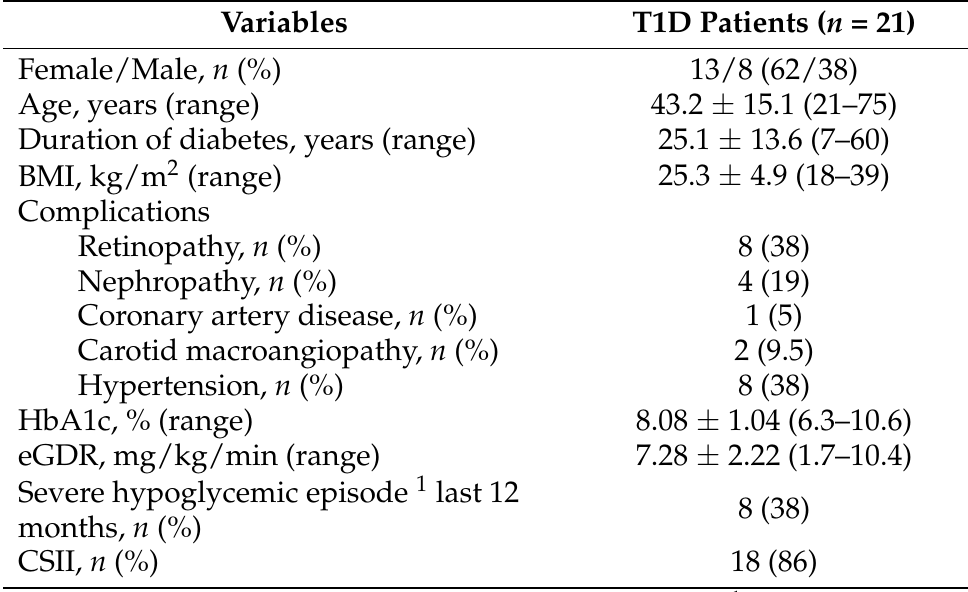
Table 1. Baseline clinical characteristics of the patients included in the